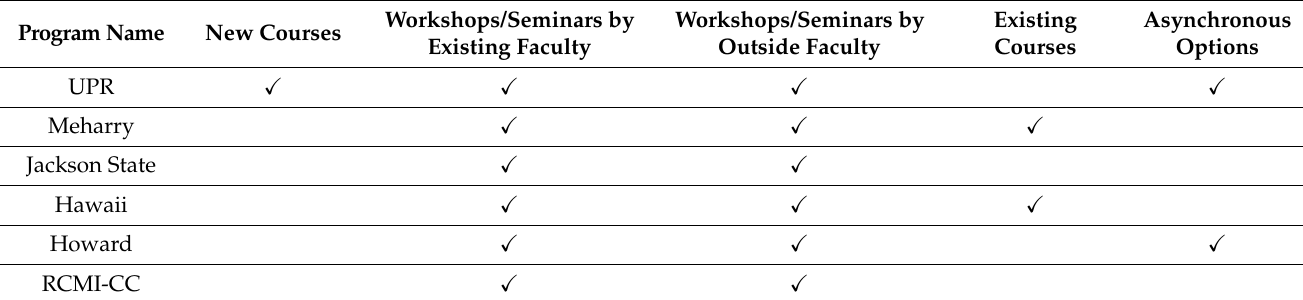
Table 5. Summary of program instruction.